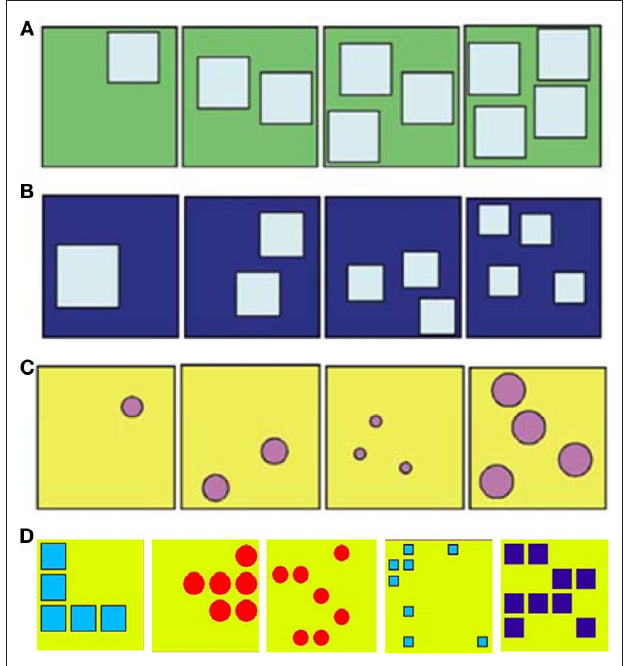
Figure 1 | examples of stimuli used in experiment 1 (A–C) and experiments 2A and 2B (D). Stimuli in Experiment 1: (A) element size-constant, (B) overall surface area-constant, and c) random element size groups of stimuli. Stimuli in Experiments 2A and 2B: (D) an example of the computer generated stimuli for numerosities